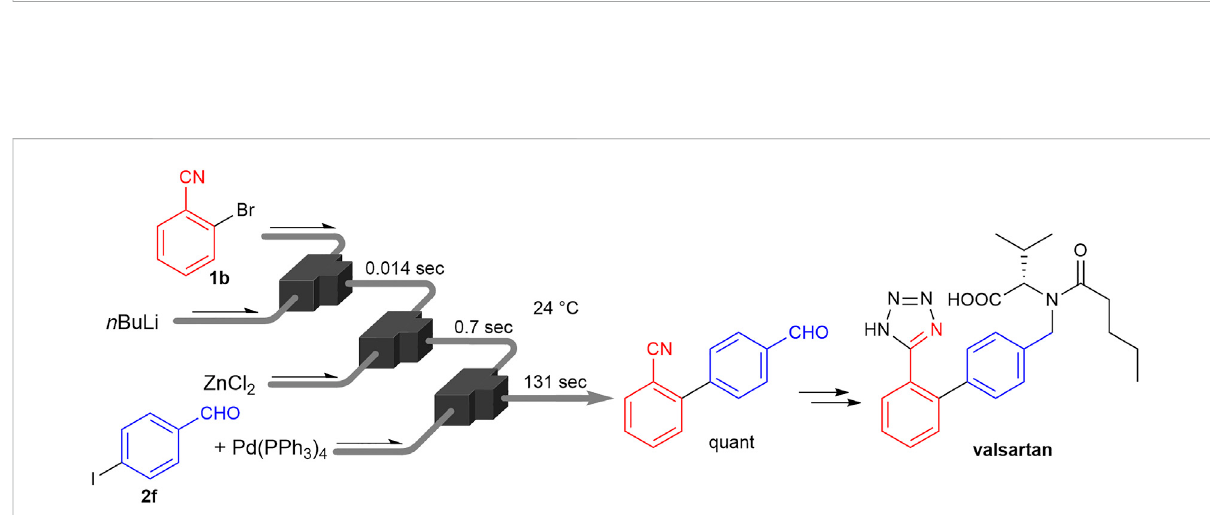
FIGURE 3 Full-room-temperature process of integrated lithiation-metalation-coupling for synthesizing the key intermediate of valsartan.